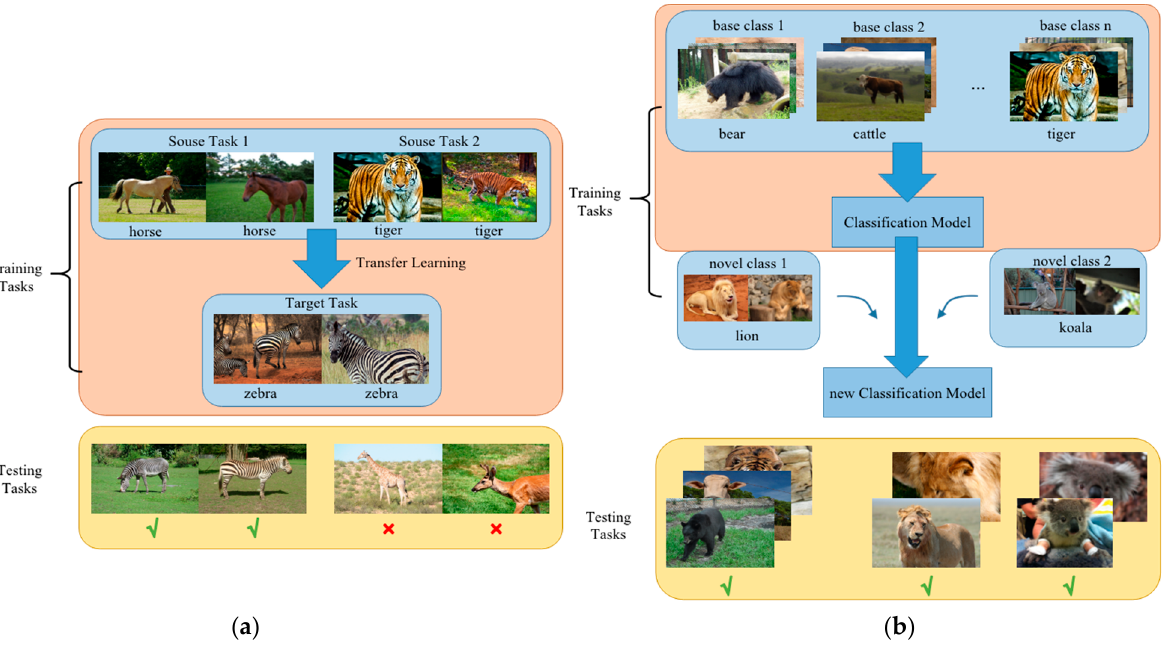
Figure 1. Transfer learning and few-shot learning. The transfer learning method is shown as ( a ), and the few-shot learning method is shown as ( b ). Transfer learning methods recognize small sample objects that are similar to the objects in training sets, and their categories are included in training sets. Few-shot learning methods train the models (update the model parameters) on multiple subtasks, in order to make the models ‘learn to learn’; the content of the testing and training tasks can be completely different.